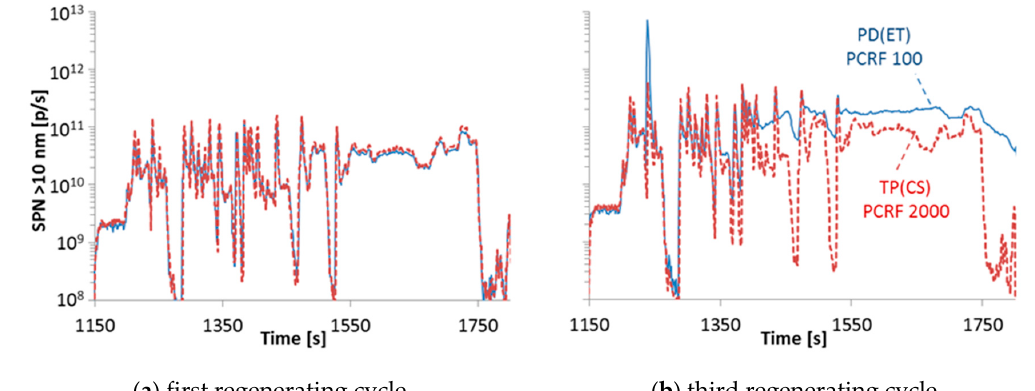
Figure 5. Real time solid particle number (SPN) emissions > 10 nm ( a ) during the last 600 seconds the first and ( b ) third regenerating hot start WHTCs measured with the “Golden” system with catalytic stripper at the tailpipe TP(CS) and the PMP system with evaporation tube at the proportional partial flow system PD(ET) for DPF #4. PCRF = Particle number concentration reduction factor.